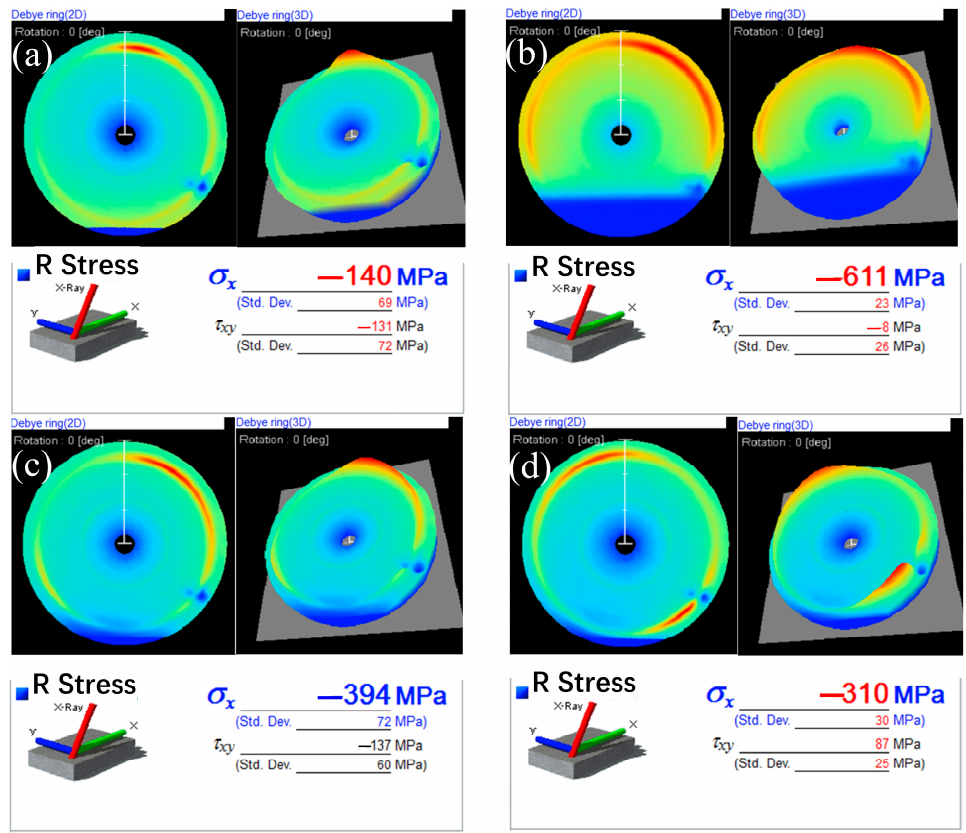
Figure 10. The Debye rings and their residual stresses ( σ x and τ xy ): ( a ) CSPB STACER; ( b – d ) winding and stabilization STACER under 480 °C + 4 h, 520 °C + 4 h, and 560 °C + 4 h,